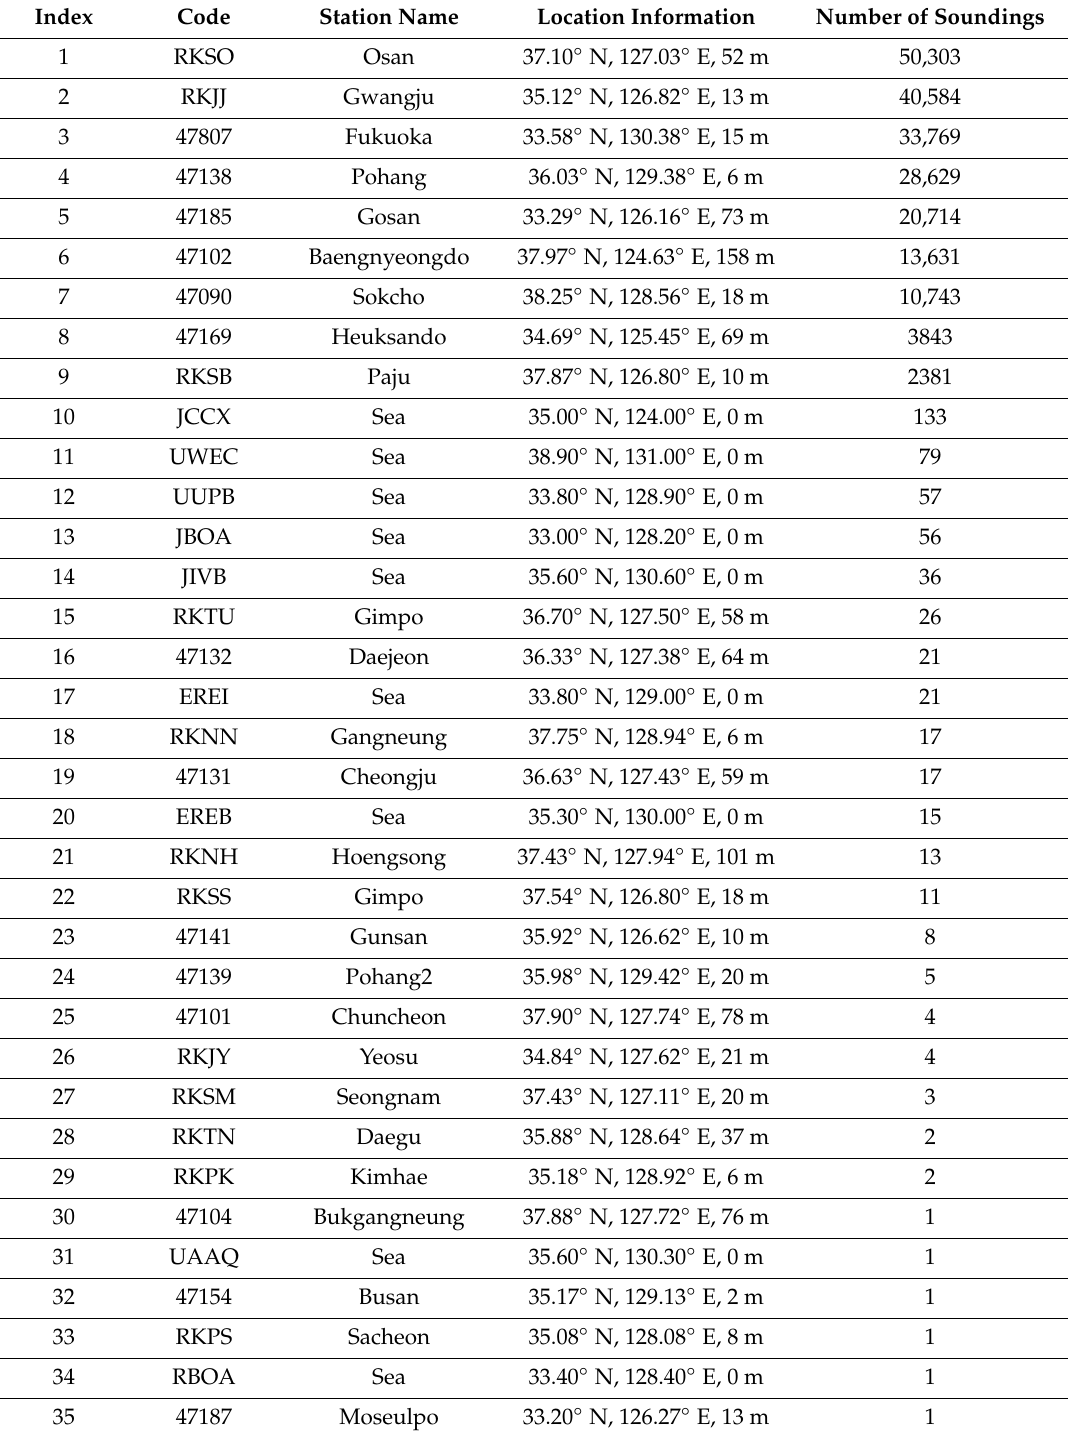
Table 1. Information on radiosonde